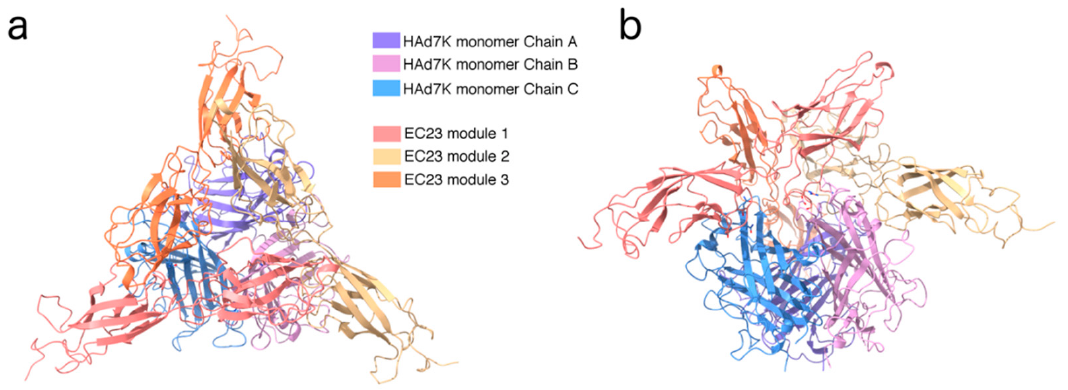
Figure 3. Structure of HAd7K-(EC23) 3 viewed along the 3-fold axis ( a ) or from the side ( b ). Each monomer is colored differently according to the legend.